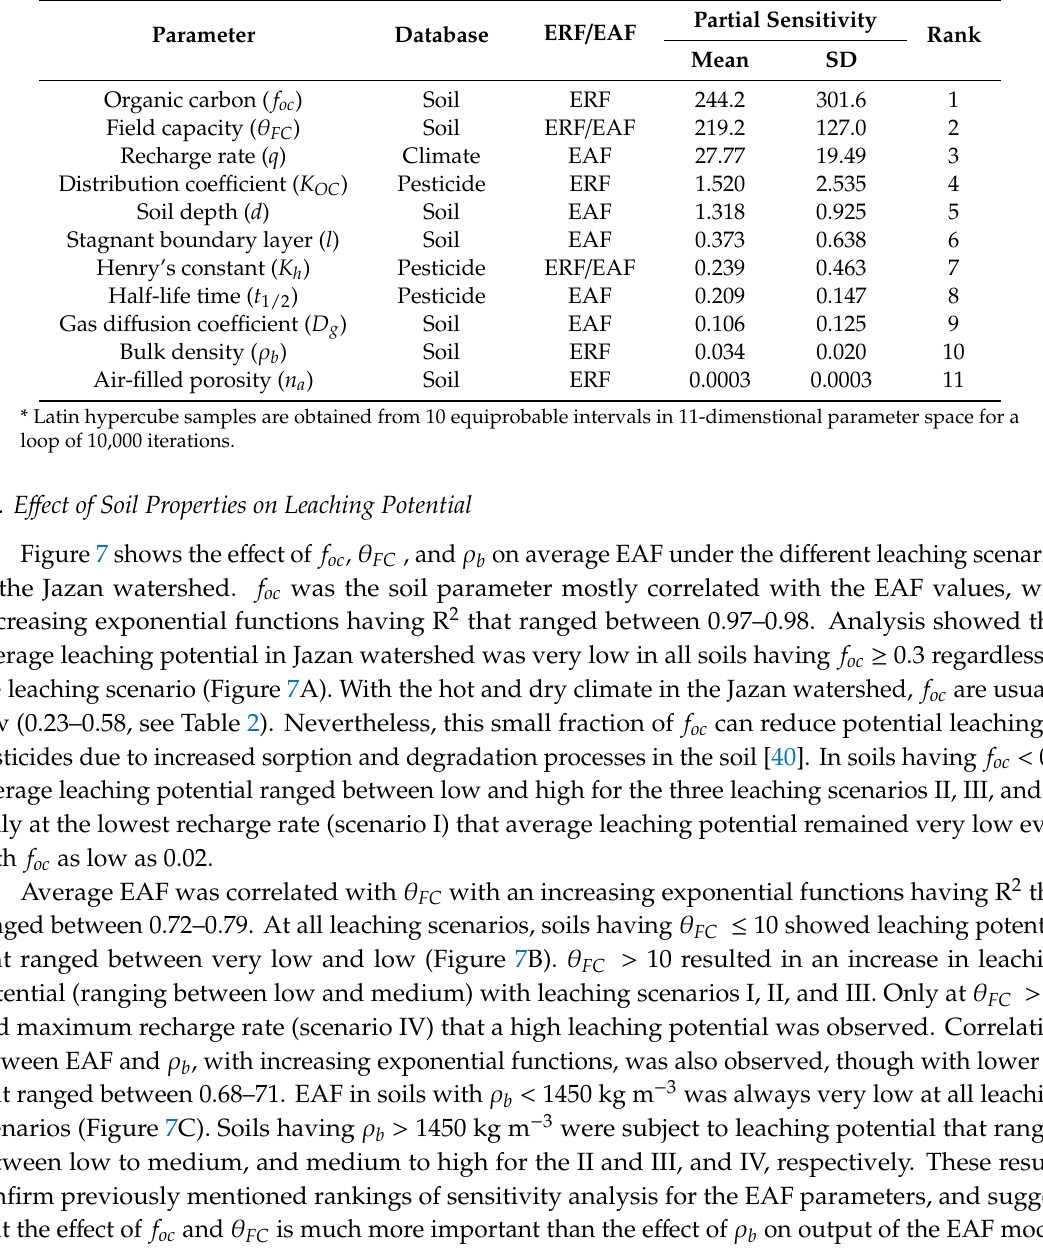
Table 5. Latin-Hypercube-one-factor-At-a-time (LH-OAT)* sensitivity analysis of the di ff erent